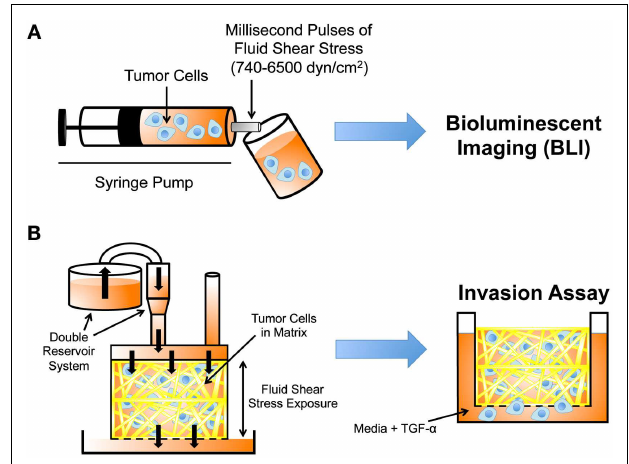
FIGURE 4 | Experimental techniques to study cancer cell mechanotransduction. (A) Microfluidic protocol to deliver millisecond pulses of fluid shear stress to tumor cells (Barnes et al., 2012).Tumor cell resistance to fluid shear stress determined using bioluminescent imaging (BLI). (B) Darcy flow apparatus for the application of fluid shear stress in 3D to tumor cells embedded in collagen (Qazi et al., 2011). Shear stress-exposed cells are then placed in a modified Boyden chamber to measure their migratory and invasive potential in the presence ofTGF- α